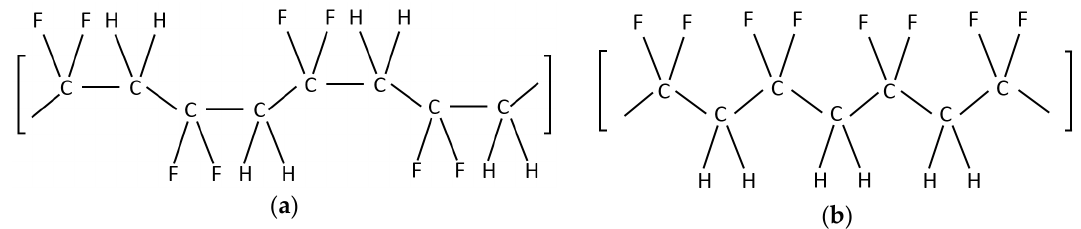
Figure 3. Schematic of polyvinylidene ‐ fluoride (PVDF) structure ( a ) α phase and ( b ) β phase.